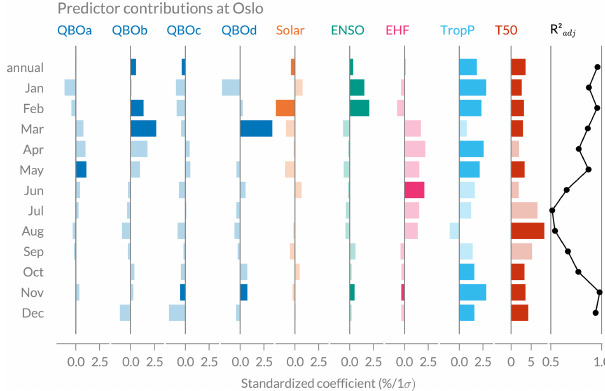
Figure 6. Predictor contribution to the regression fit at Oslo for the annual regression fit and individual monthly fits. The standard- ized coefficients describe the percentage change in ozone for a 1 σ change in the predictor. Pale colour bars indicate that the predic- tor’s contribution to ozone is not significant ( p value of the coeffi- cient < 0 . 05). The last panel on the right shows the adjusted coef- ficient of determination ( R 2 ) for the annual and all monthly fits. adj Note that the range of the x axis is different for T50 than for the other